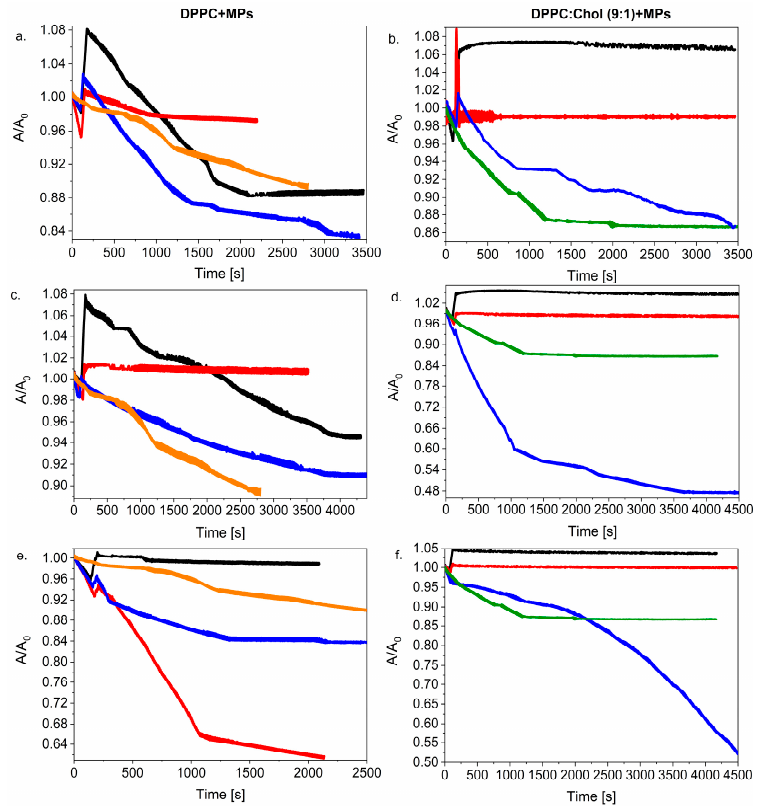
Figure 5. Relative area–time curves for various volumes of silica particles (5, 10 and 20 µL) injected on DPPC or DPPC:Chol (9:1) with concentration of 2.5% ( a , b ), 1.0% ( c , d ) or 0.1% ( e , f ) (black line— 20 µL MPs; red line—10 µL MPs; blue line—5 µL MPs; orange line—DPPC (without MPs); green line—DPPC:Chol (9:1) (without MPs)).